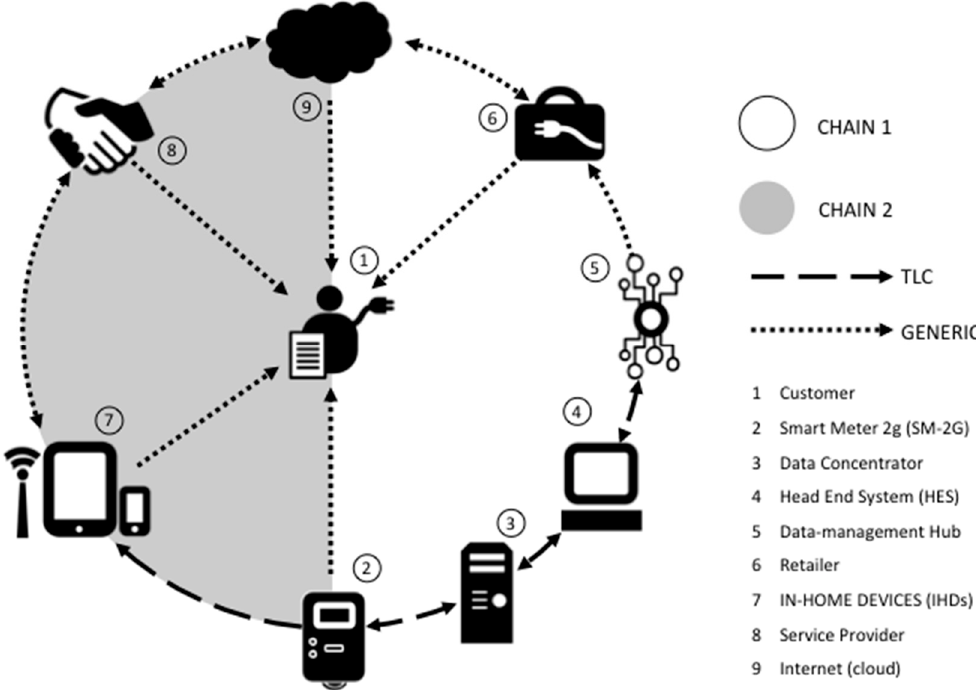
Figure 2. Second generation Smart Metering: Advance Metering Infrastructure (AMI) and chain 1/chain 2 explanation.